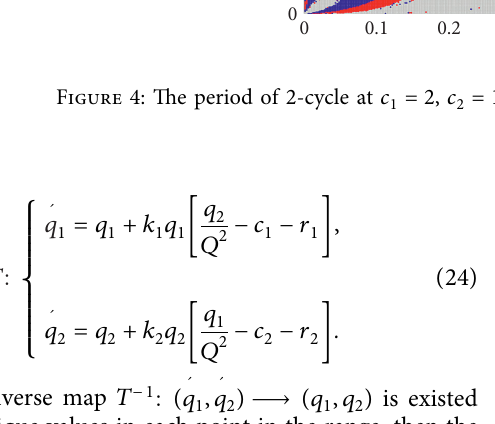
Figure 4: The period of 2-cycle at c